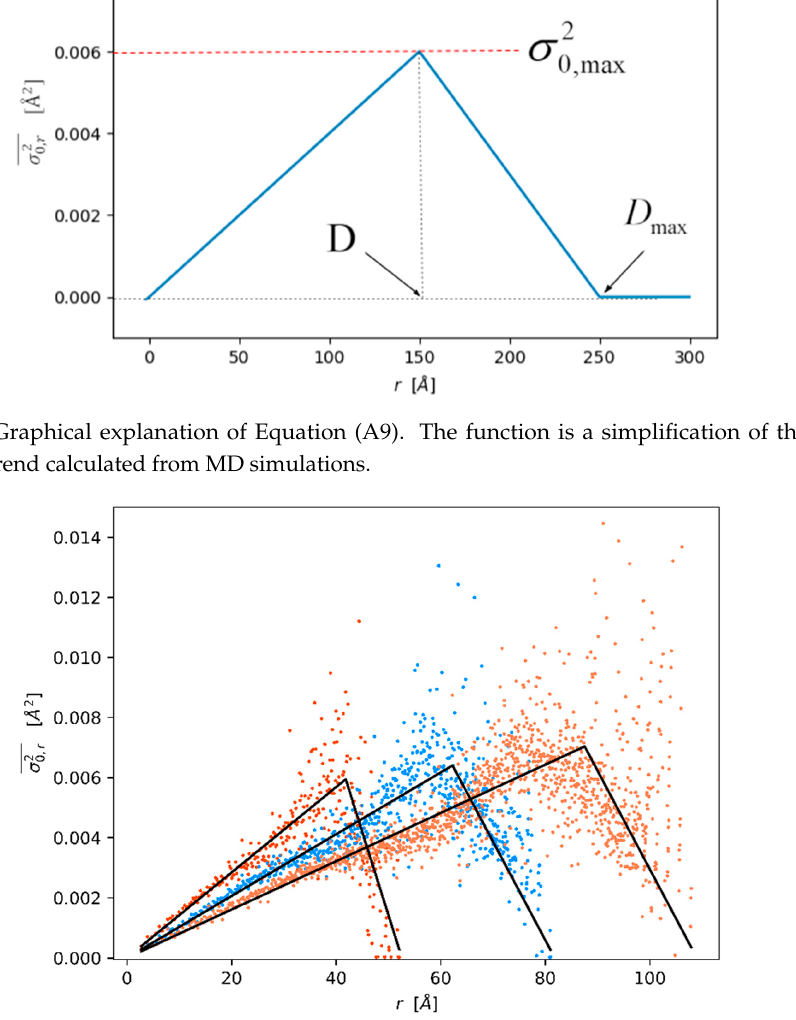
Figure A2. Static MSRD results from Figure 3 in the main text with static model of Equation (A9). Best fit of σ 2 0, max are, respectively, 0.00594 (D = 41.84 Å), 0.00640 (D = 62.26 Å), and 0.00703 (D = 87.54 Å).